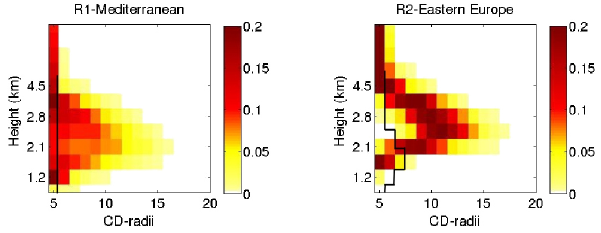
Figure 10. Spatial comparison of the simulated cloud liquid- water path (gm − 2 ) (CTRL and MOD) with observations from the MODIS sensor onboard the Aqua satellite for the JJA